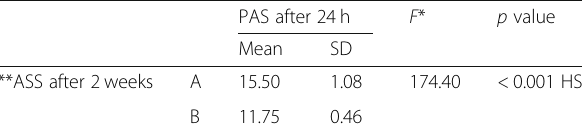
Table 5 Relation between Pleural Adherence Score (PAS) after 24 h and Absent Sliding Score (ASS) after 2 weeks